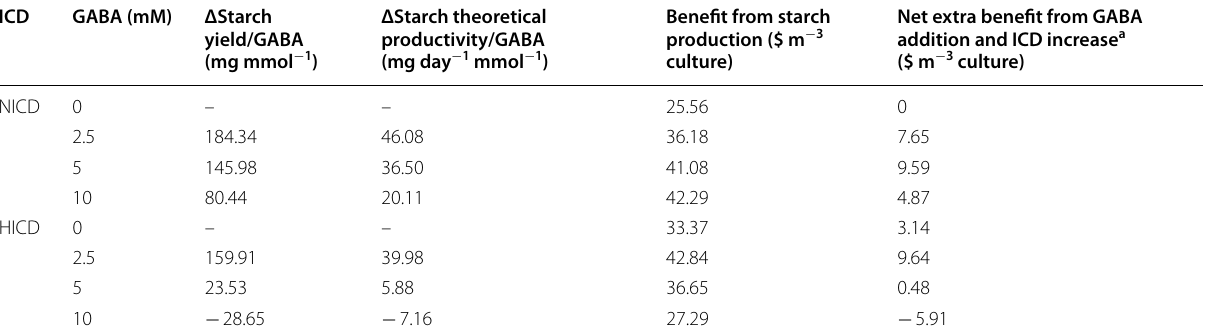
a The net extra benefit was estimated by assuming a biomass seed production cost of 2.71 $ kg − 1 (Muhammad et al. 2021) and GABA cost of 11.5 $ kg − 1 (Xiong et al. 2017)